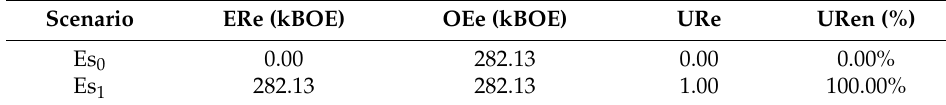
Table 17. The use of REs in the electric power supply.